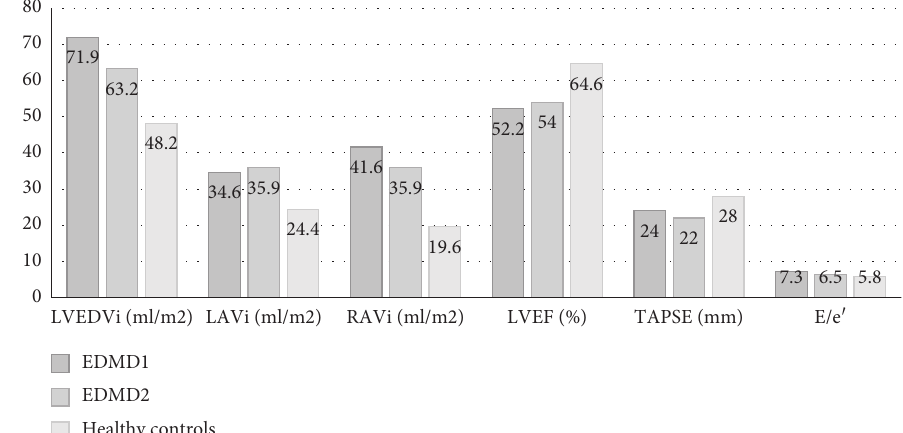
Figure 1: Cardiac chamber volumes and systolic and diastolic parameters of EDMD1, EDMD2, and healthy controls. E/e’: mitral early peak velocity/annular velocity; LAVi: left atrial volume index; LVEF: left ventricular ejection fraction; LVEDVi: left ventricular end-diastolic volume index; RAVi: right atrial volume